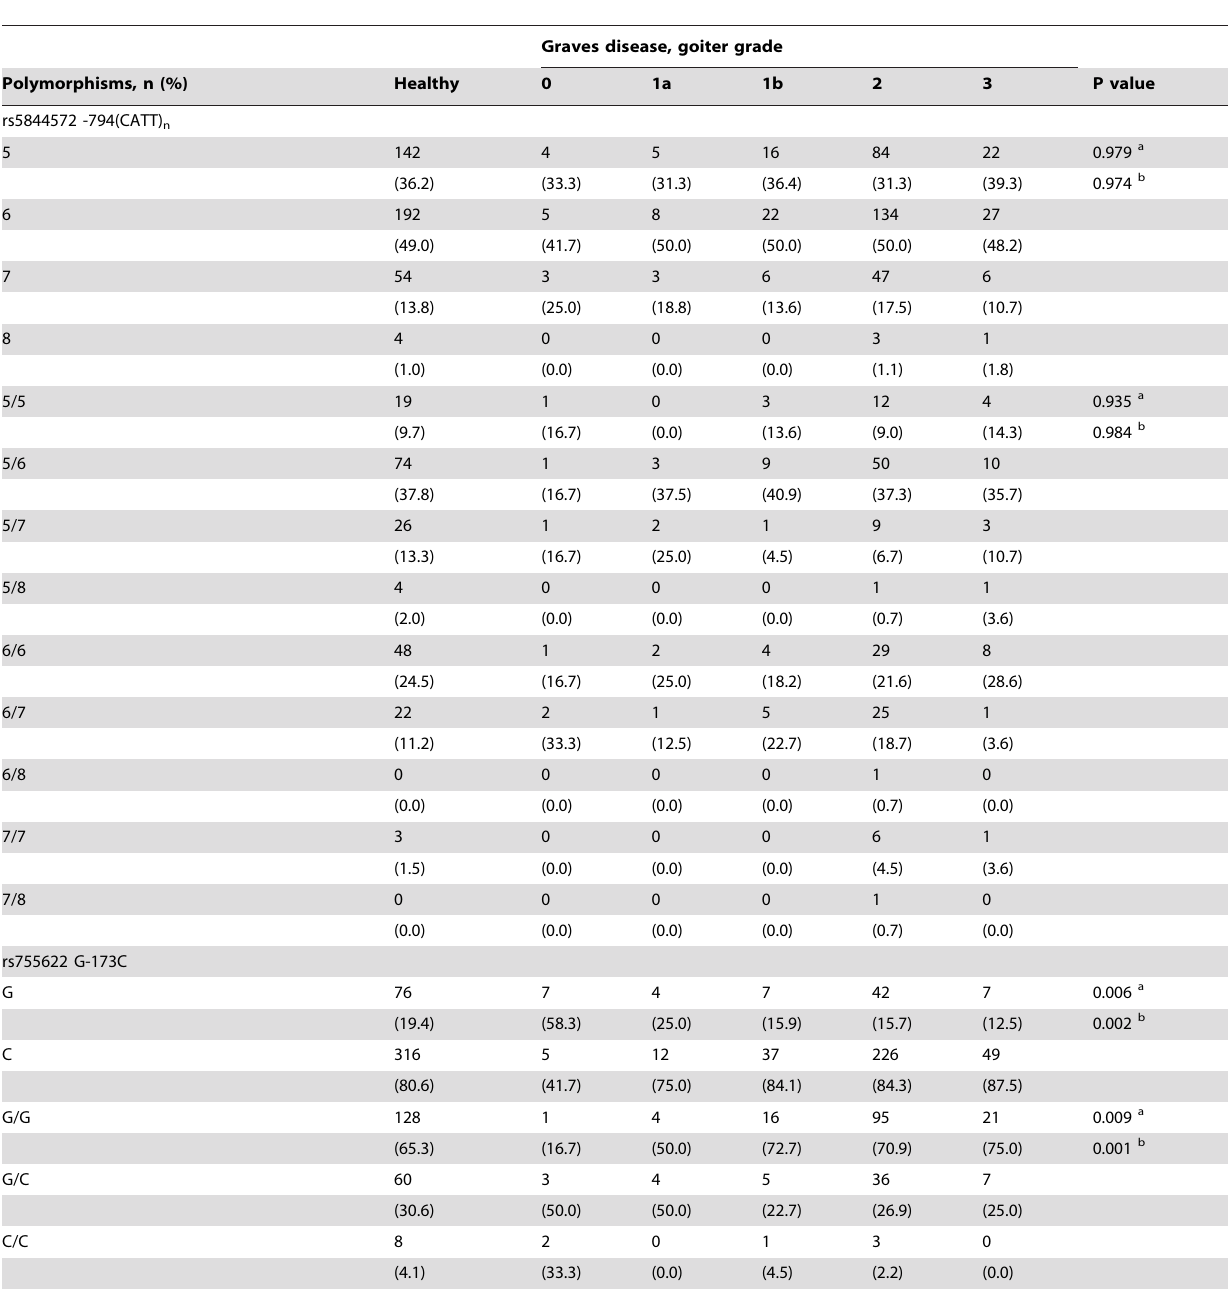
Table 3. Distributions of alleles and genotypes of the MIF polymorphisms with respect to the severity of goiter in patients with untreated Graves disease.